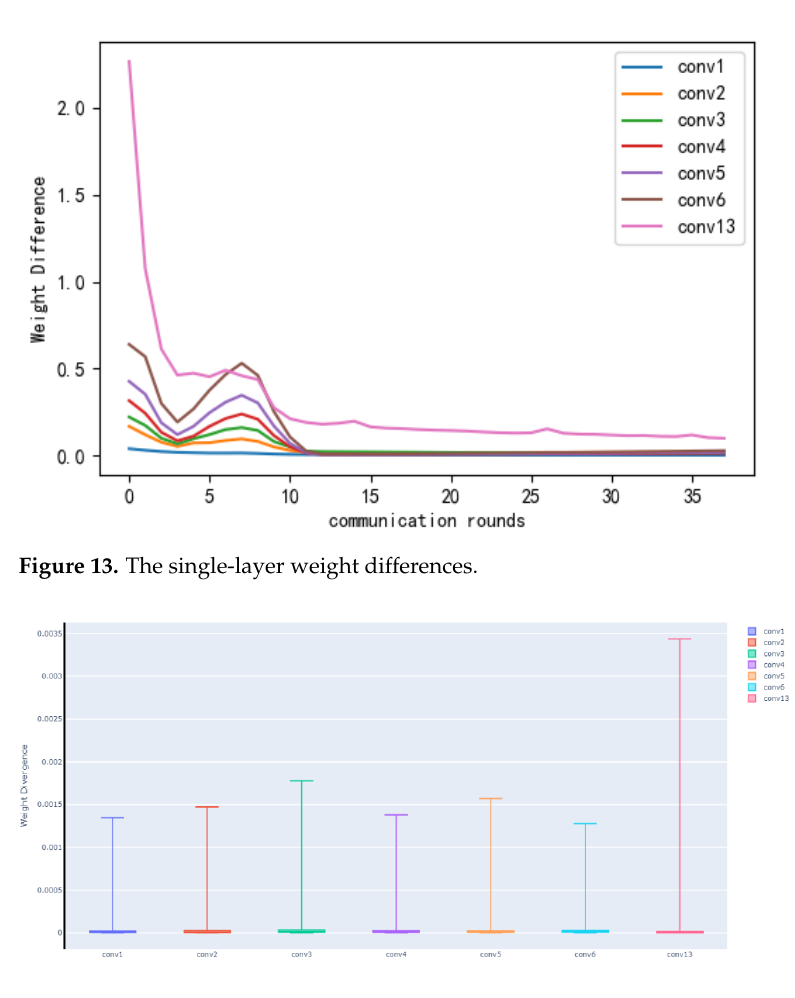
Figure 14. The single-weight differences in each layer.